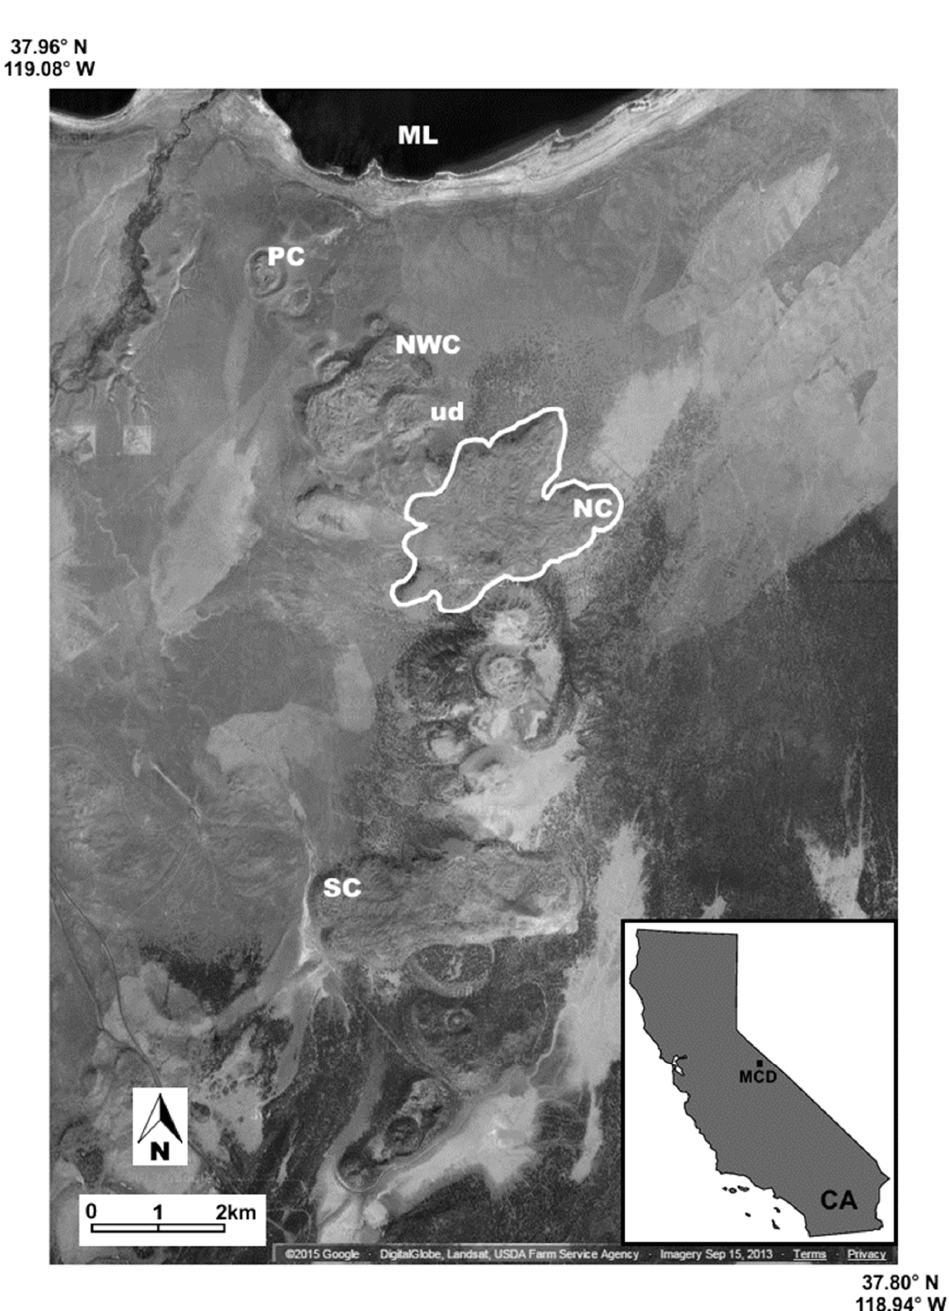
Figure 2. High-resolution visible satellite image from Digital Globe (within Google Earth) the Mono Craters and Domes with North Coulee (NC) outlined in white. Other features include: Mono Lake (ML), Panum Crater (PC), Northwest Coulee (NWC), South Coulee (SC), and the informally-named Upper Dome (UD). Inset shows the state of California with the study area (MCD) denoted by the black box.